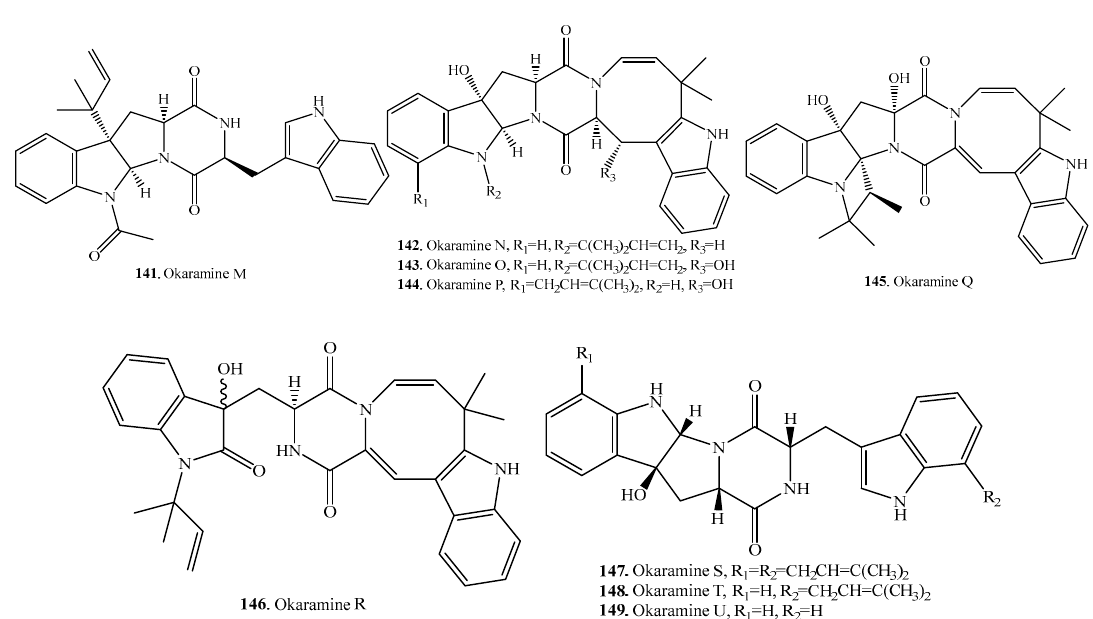
Figure 2. Structures of the tryptophan-tryptophan cyclodipeptide analogs isolated from fungi.